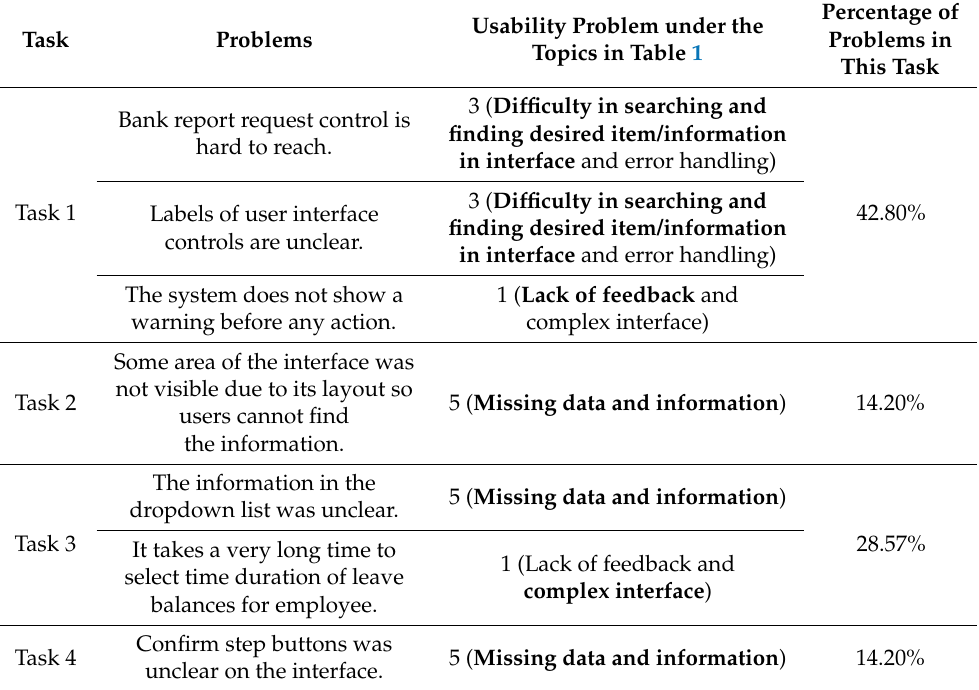
Table 6. Usability problems found during the usability testing